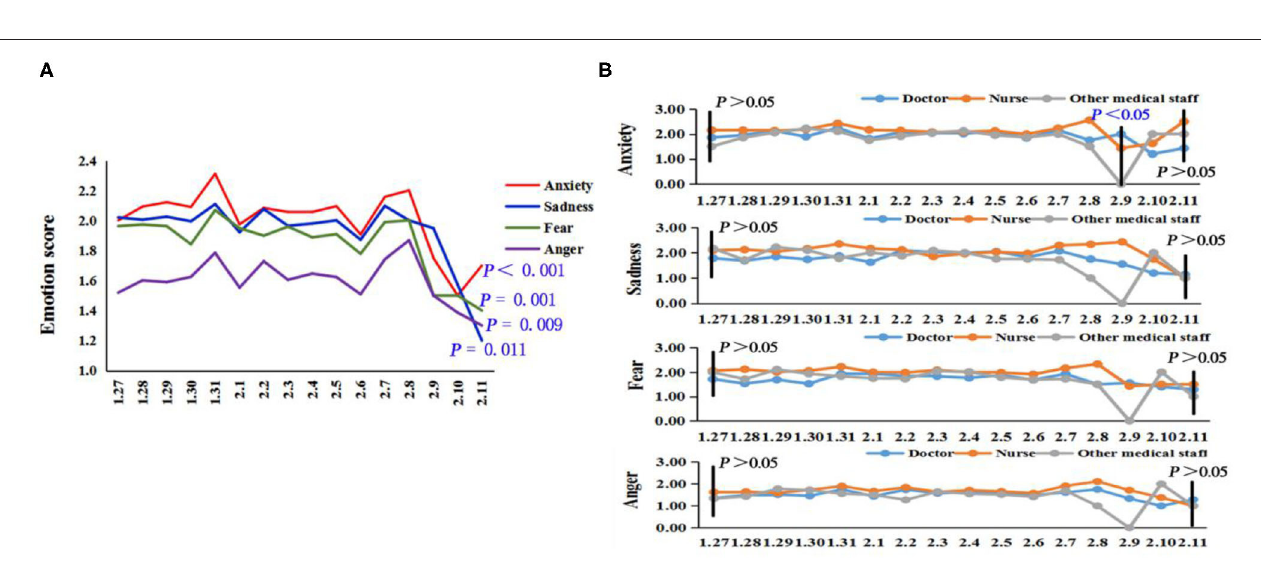
FIGURE 2 | The trend of negative emotions over time. (A) The overall emotional trend of frontline medical staff. (B) The emotional trend of different medical professionals.